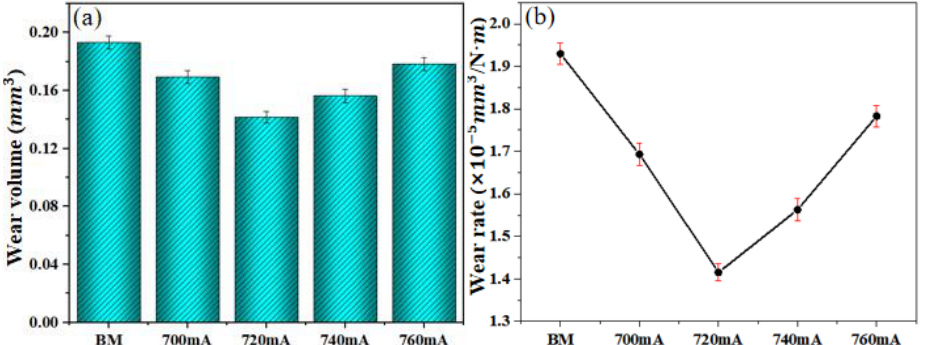
Figure 8. Nickel-base alloy wear results from differently focused current electron beam scanning: ( a ) Wear Volume, ( b ) Wear Rate.